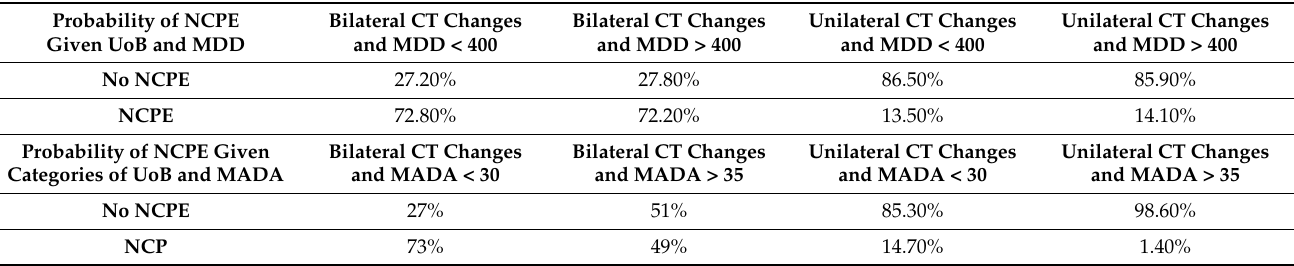
Table 12. The heat-mapped, conditional probabilities of NCPE given the different states of MDD, MADA and UoB. The results suggest that the presence of NCPE is more significantly influenced by the presence of bilateral ground-glass or consolidative CT scan